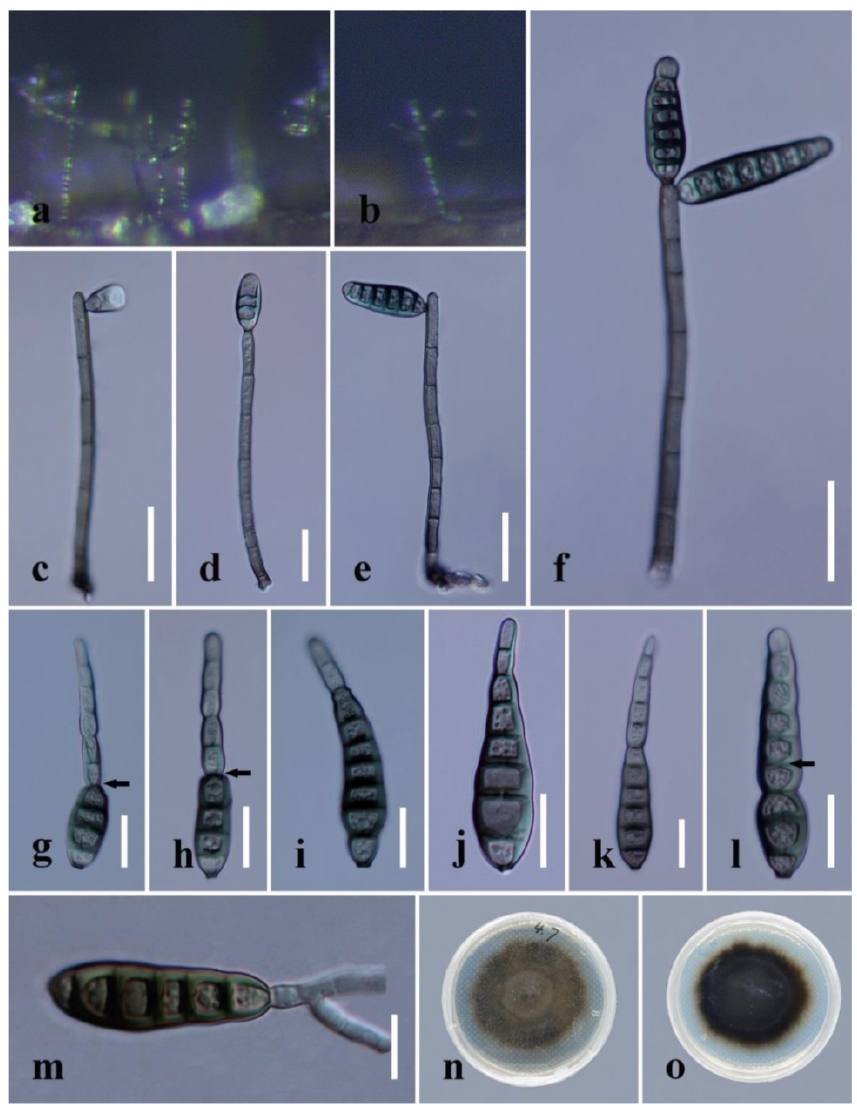
Figure 10. Distoseptispora dehongensis (from MFLU 17–1671). ( a , b ) Colonies on natural substrate. ( c – f ) Conidiophores with conidia. ( g – l ) Conidia. The arrows in g and h indicate conidial percurrent proliferating points. The arrow in l points to a gap in the middle of the septum, which indicates the distosepta. ( m ) Germinated conidium. ( n ) Colony on PDA (from front). ( o ) Colony on PDA (from reverse). Scale bars: ( c – f ) 20 µ m; ( g – l ) 15 µ m; ( m ) 10 µ